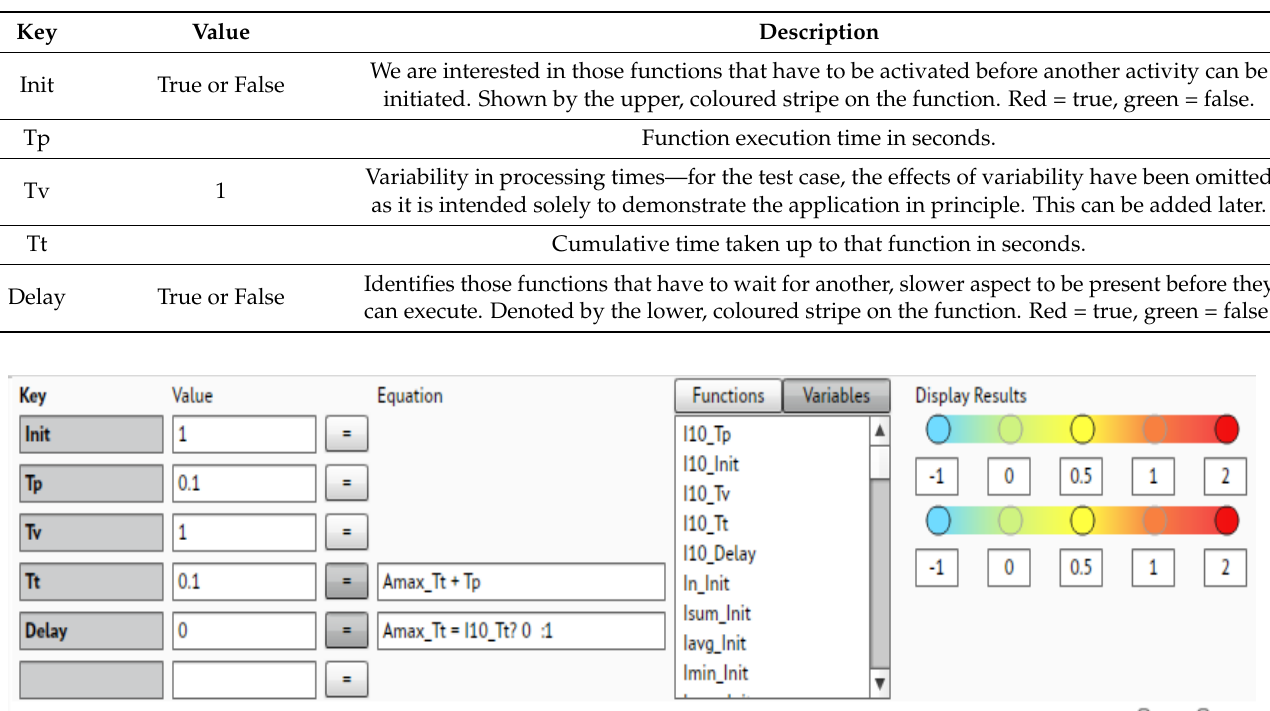
Table 2. Key–value pairs for the ‘work as imagined’ FRAM.